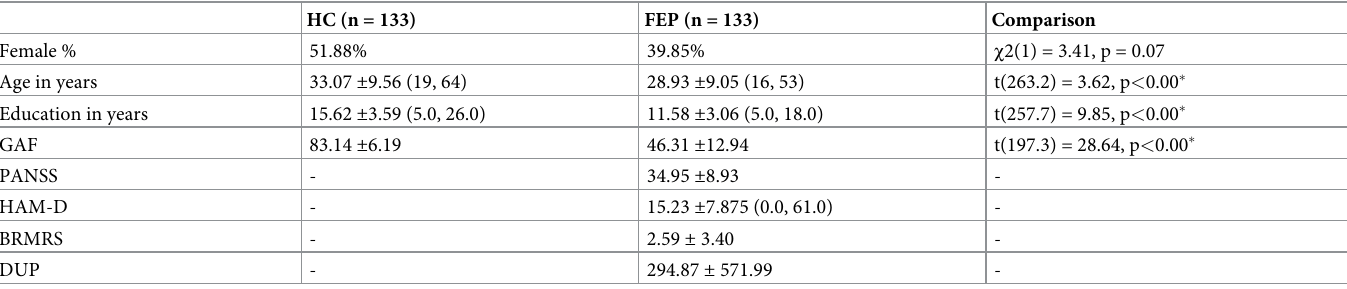
Table 1. Sociodemographic and clinical data of the sample of FEP and